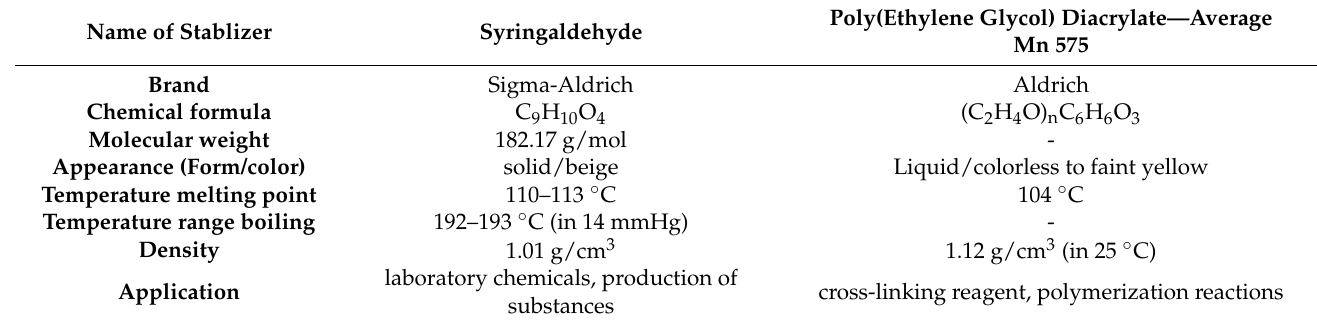
Table 2. Characterisation of stablizers: Syringaldehyde [29] and Poly(ethylene glycol) diacrylate—Average Mn 575 [30]. Name of Stablizer